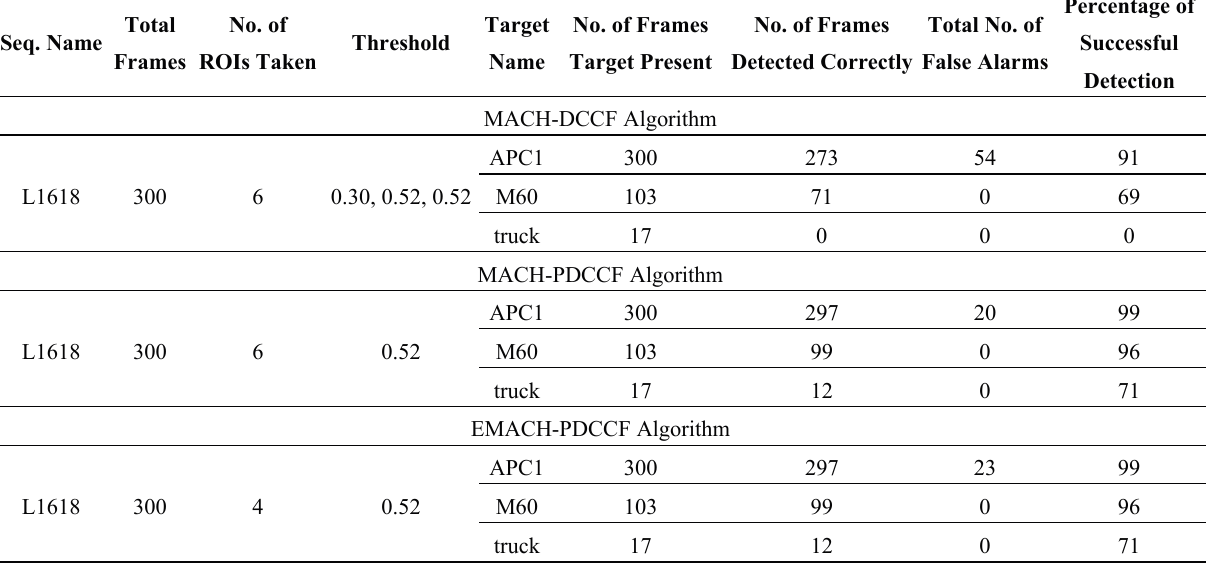
Table 10. Tracking results of three-target